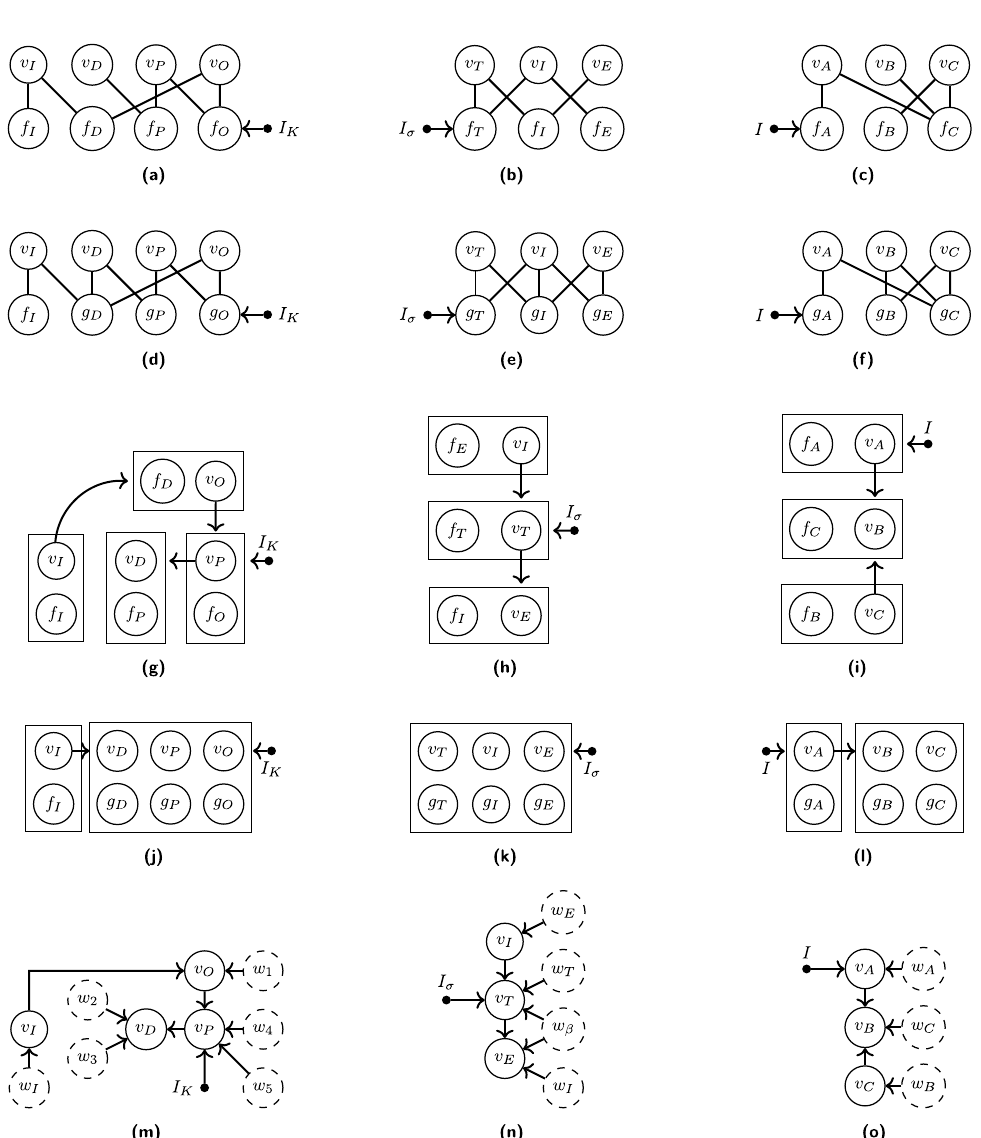
following way. Both the derivative X t ˙ i ( ) and the corresponding variable X t i ( ) are associated with the same vertex v i . The natural labelling is used for the di ff erential equations, so that a vertex g di ff erential equation for X t ˙ i ( ) . We then construct the dynamic bipartite graph V F E , , dyn (cid:2) ⟩ with variable vertices v and the corresponding dynamical equation vertices g F F i ∈ are added as well in case the dynamical system consists of a combination of dynamic and static equations. The edge set E has an edge v f i ) − whenever X t i ( ) appears in the static equation f j . In addition, there are edges v